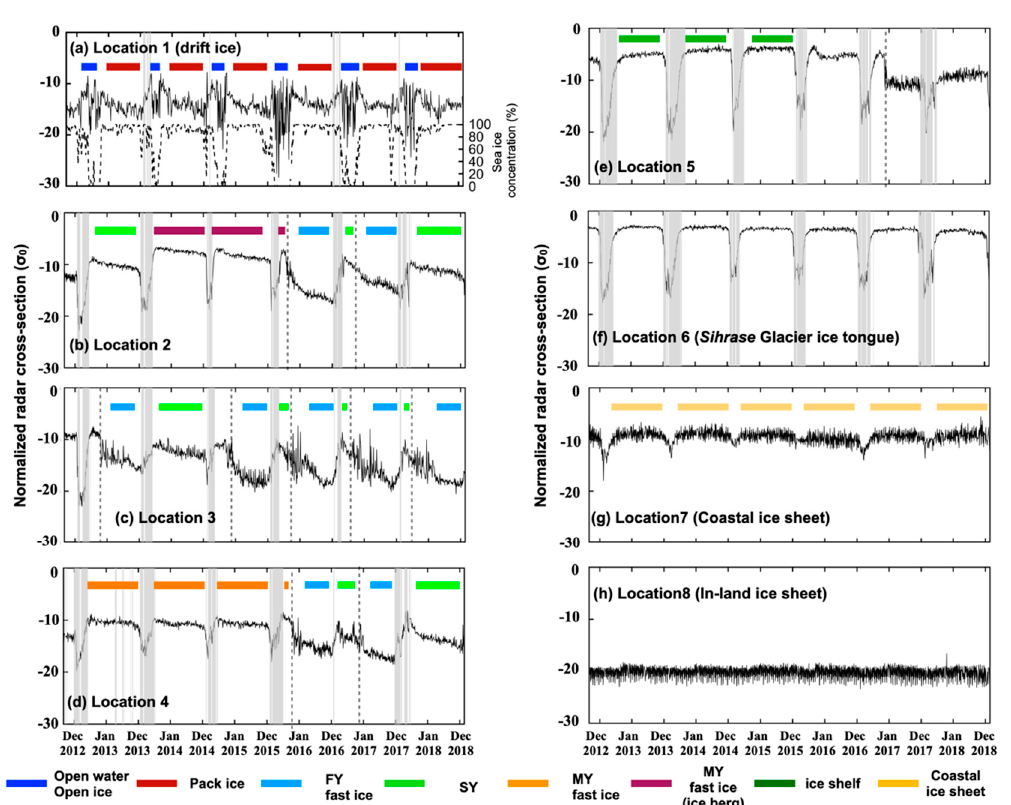
Figure 3. Time series of ASCAT σ 0 and sea ice concentration ( SIC ) from October 2012 to September 2018 for the eight locations in the Antarctic coastal area shown in Figure 1. The black bold lines donate the σ 0 value for each ice area. The black dashed line, which is only shown in ( a ), is the SIC , and the gray shading indicates time periods of continuous snow melting on the sea ice. The broken vertical line indicates a major period of breakup in Lützow-Holm bay. The colored horizontal bar indicates the type of ice and over the period of their existence, as well as the time periods extracted to calculate the threshold for classifying each type of ice.